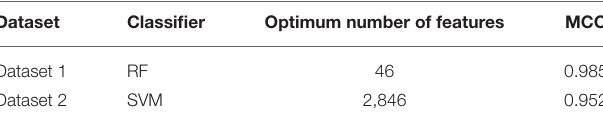
TABLE 1 | The classification performance on two